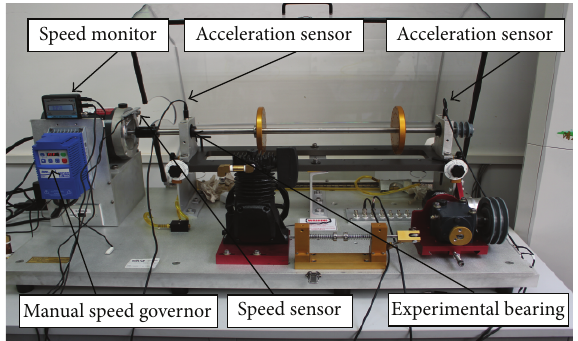
Figure 2: The MFS-MG experimental